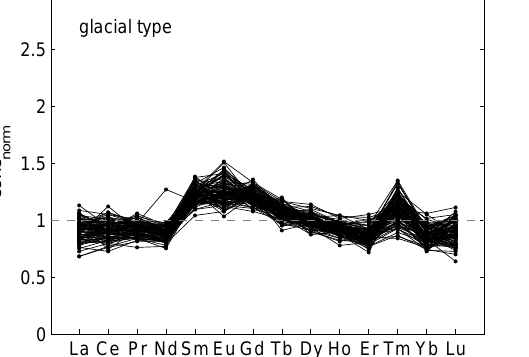
Fig. 4. Typical Holocene REE patterns. The characteristic variations in the Eu-anomaly and the HREE/LREE ratios are clearly identified. See text for the characterisation of the different REE